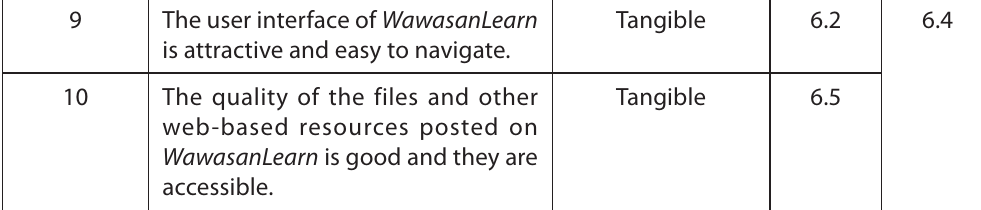
Table 2 Service quality level of satisfaction: Mean scores